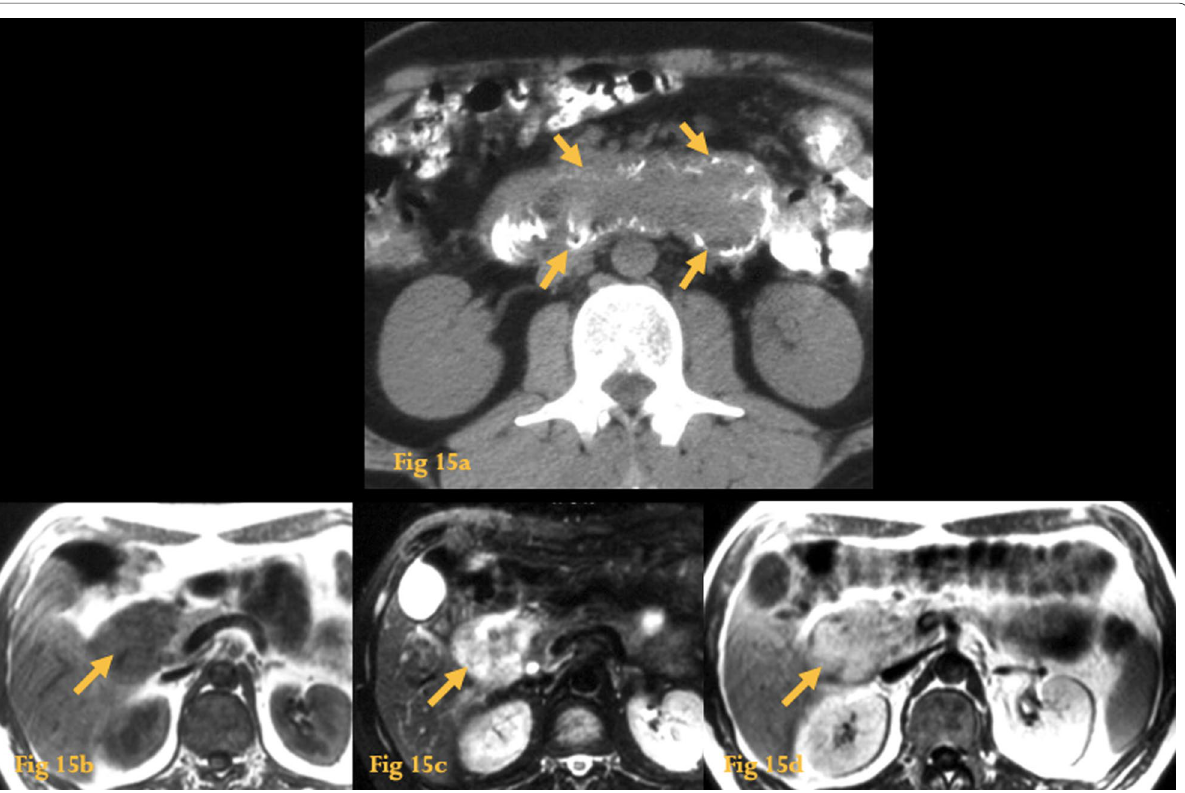
Fig. 15 Hamartoma of Brunner’s glands. Unenhanced CT ( a ) shows a voluminous polypoid lesion originating in the duodenal bulb and reaching D4, with soft‑tissue density and a lobulated contour (arrows). MRI of the same patient shows that the lesion (arrows) is heterogeneously hypointense on T1w images ( b ), hyperintense on FS T2w images ( c ), with enhancement after iv administration of gadolinium ( d